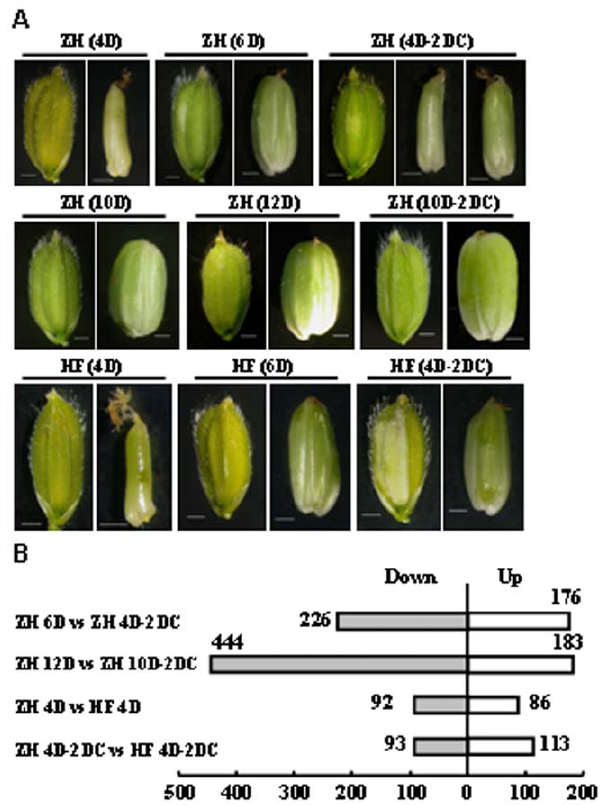
Figure 8. Regulated genes in chilling response of rice seeds. A. Low temperature treated rice seed of Zhonghua 11 (ZH) and Hanfeng (HF). Developing seeds of ZH and HF at 4 DAF were treated at 14 u C for 2 days (4 D-2 DC) and seeds developed for 6 days (6 D) were used as control. Developing seeds of ZH at 10 DAF were treated at 14 u C for 2 days (10 D-2 DC) and ZH seeds developed for 12 days (12 D) were used as control. Appearance of glumes and grains were shown under each treatment. Bar=1 mm. B. Numbers of genes regulated by low temperature. ZH or HF represents the Zhonghua 11 or Hanfeng variety. ‘‘C’’ indicates the low temperature treatment; ‘‘D’’ indicates days after fertilization. Rice plants at 4 or 10 days after fertilization were treated with low temperature (14 u C) for 2 days (ZH 4D-2DC, ZH 10D-2DC and HF 4D-2DC), with corresponding controls growing at normal temper- ature (ZH6 D, ZH 12D, HF6D). In each comparison, ‘‘Up’’ indicates number of genes higher expressed in later group, whereas ‘‘Down’’ indicates number of genes lower expressed in later